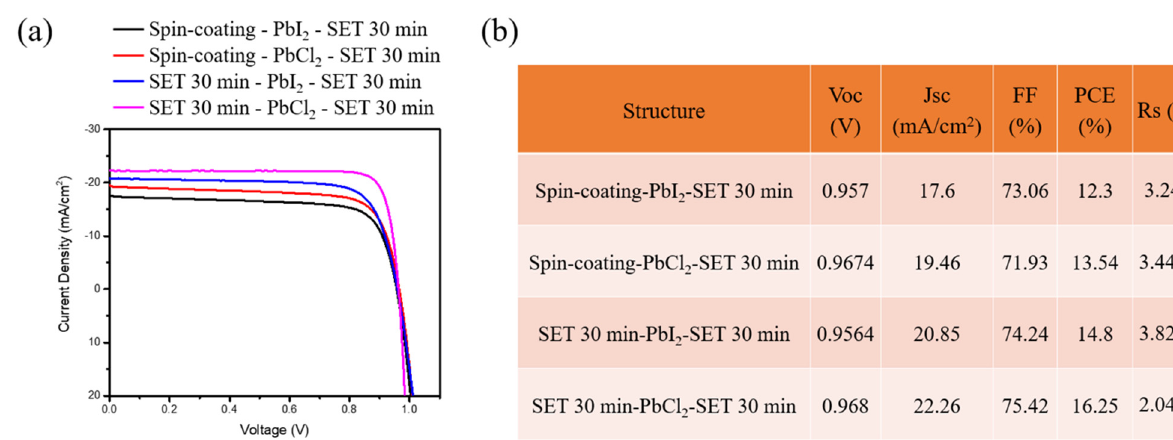
Figure 6. ( a ) J–V characteristic of perovskite solar cells for different sandwich structures ( b ) Photovoltaic parameters of perovskite solar cell.